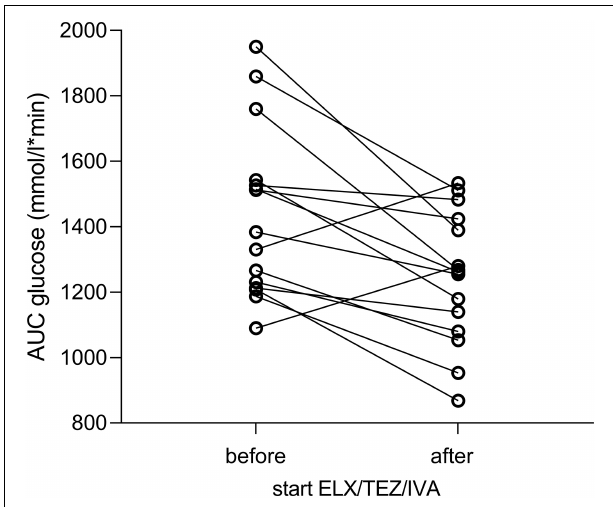
FIGURE 4 | Area under the curve of plasma glucose levels before and after initiating ELX/TEZ/IVA therapy in people with cystic fibrosis. The area under the curve (AUC) decreased for plasma glucose (in mmol/l*min) after introducing ELX/TEZ/IVA ( p = 0.008).